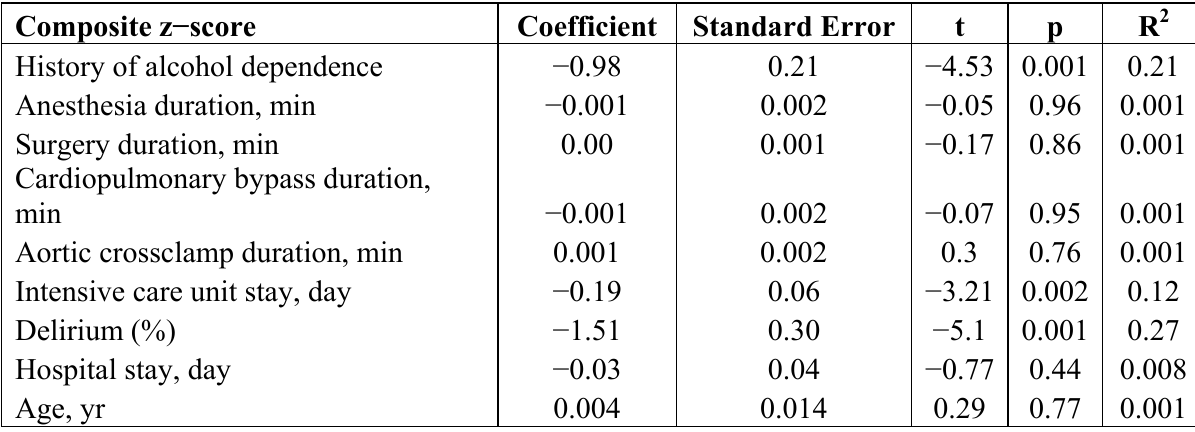
Table 4. Results of univariate linear regression